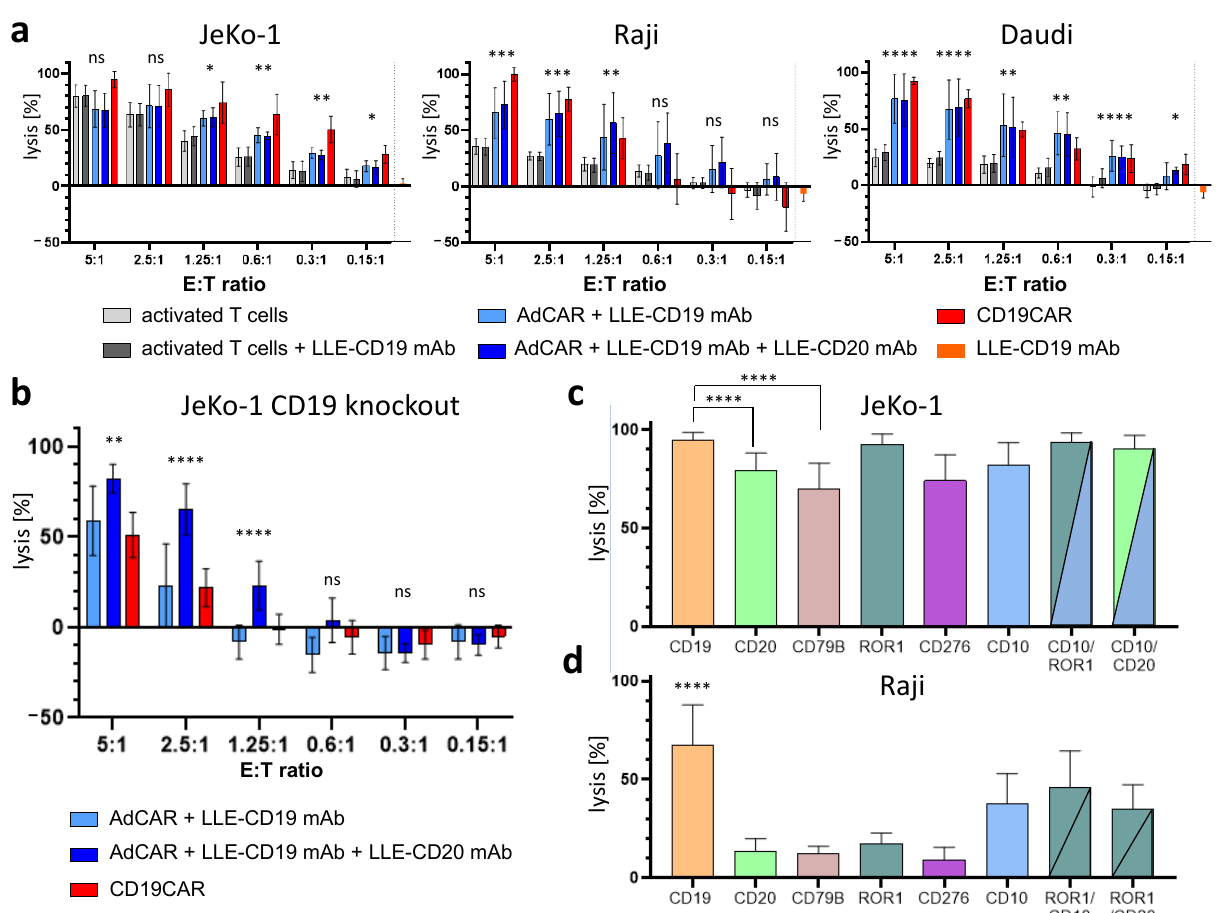
Figure 4. Multitargeting with AdCAR T cells prevents immune evasion in lymphoma. ( a ) Non- transduced activated T cells with or without 1 ng/mL LLE-CD19 mAb, AdCAR T cells with or without 1 ng/mL LLE-CD19 mAb +/ − 1 ng/mL LLE-CD20 mAb, or conventional CD19CAR T cells were incubated with JeKo-1 (left), Raji (middle), and Daudi (right) at the indicated E:T ratios. Target cells only were incubated with LLE-CD19 mAb at 1 ng/mL. Target cell lysis was determined by LCA after 48 h. A statistical analysis is presented for the comparison of the AdCAR T cells + LLE-CD19 mAb versus the activated T cells. ( b ) AdCAR T cells with 1 ng/mL LLE-CD19 mAb or 1 ng/mL LLE-CD19 mAb + 1 ng/mL LLE-CD20 mAb, or conventional CD19CAR T cells were incubated for 48 h with a CD19 knockout variant of JeKo-1 (JeKo-1 CD19KO ) at the indicated E:T ratios. Target cell lysis was determined by LCA after 48 h. A statistical analysis is presented for a comparison of the combinatorial targeting (CD19 + CD20) versus the monotargeting (CD19). ( c , d ) To demonstrate the flexibility of the AdCAR system, AdCAR T cells were incubated with either JeKo-1 ( c ) or Raji ( d ) at an E:T ratio of 1.25:1 with 1 ng/mL of the indicated LLE-mAbs. Alternative target antigens can be utilized by AdCAR T cells. Combinatorial targeting was feasible and increased the engagement of the AdCAR T cells with the cancer cells. Target cell lysis was determined by LCA after 48 h. The statistical analysis demonstrates the superiority of CD19 as a target antigen compared with the alternative antigens CD20 and CD79B in JeKo-1. Targeting CD19 mediated the strongest cytolytic effect in Raji. Data shown in ( a , b ) represent the mean ± SEM of (n = 3) independent experiments in triplicate from three different donors. Data shown in ( c , d ) represent the mean ± SEM of (n = 3) independent experiments from three different donors. Statistical analysis was performed using one- way ANOVA and Tukey’s post-hoc test. ns, not significant. *, p ≤ 0.05. **, p ≤ 0.01. ***, p ≤ 0.001. ****, p ≤ 0.0001.